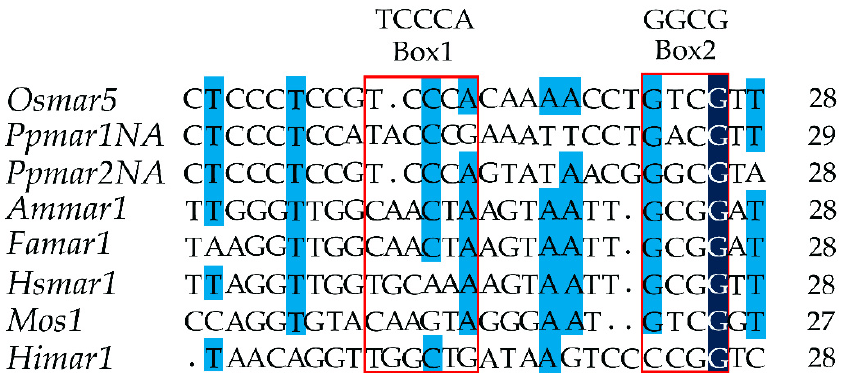
Figure 1. Structure of the Ppmar2 transposon and the non-autonomous transposon Ppmar2NA -TIRs (TIRs—terminal inverted repeats). Yellow bars represent the exons of Ppmar2 transposase, blue triangles the TIRs of Ppmar2 transposon, and dark red vertical lines the target site duplications (TSD).